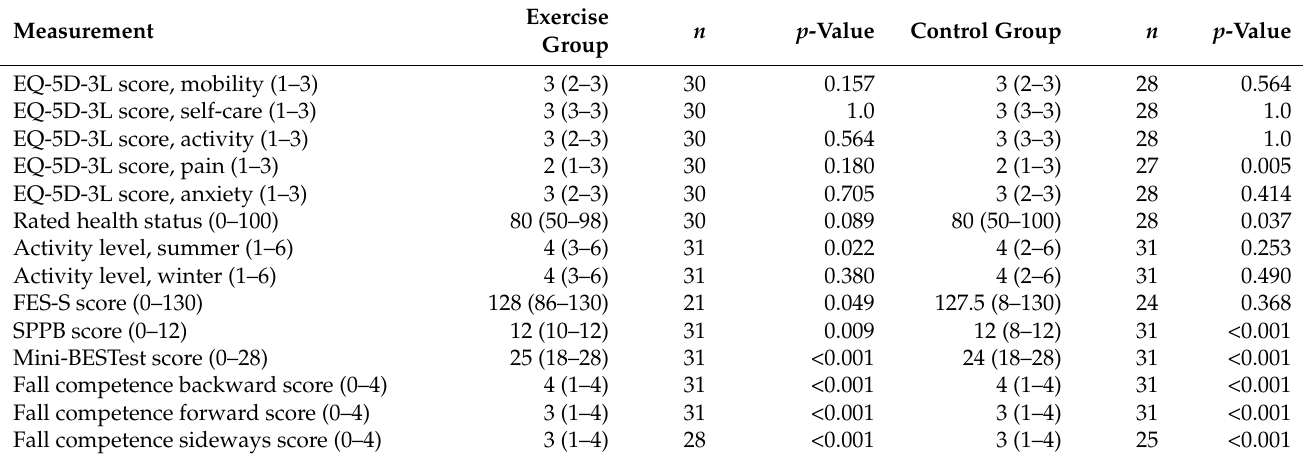
Table 3. Descriptive statistics and pre-post 12-week intervention within group